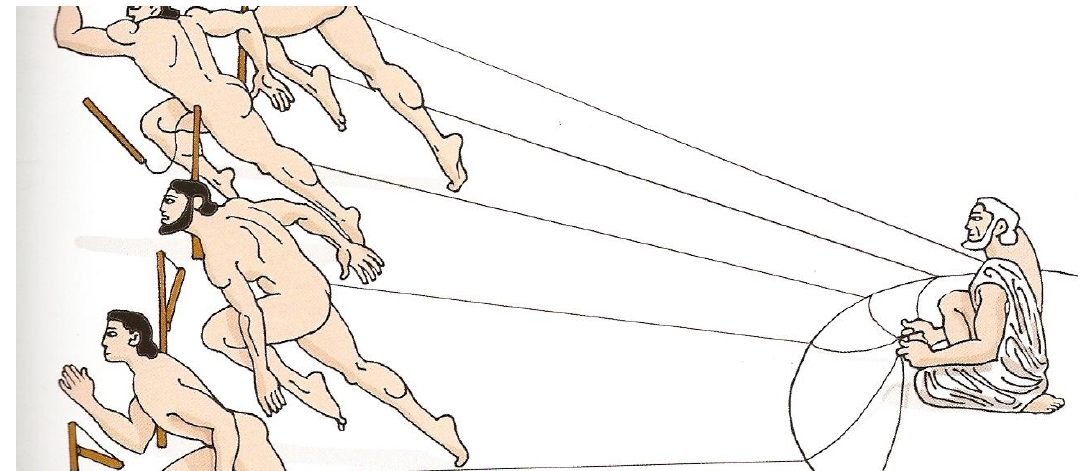
Figura 3- Partida no santuário de Posídon, no Istmo (ANDRONICOS et al, 2004,